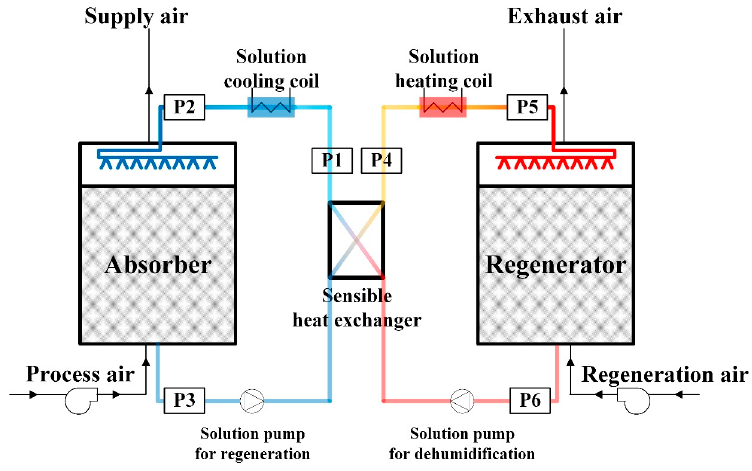
Figure 5. Schematic diagram of the liquid desiccant (LD) system simulation.